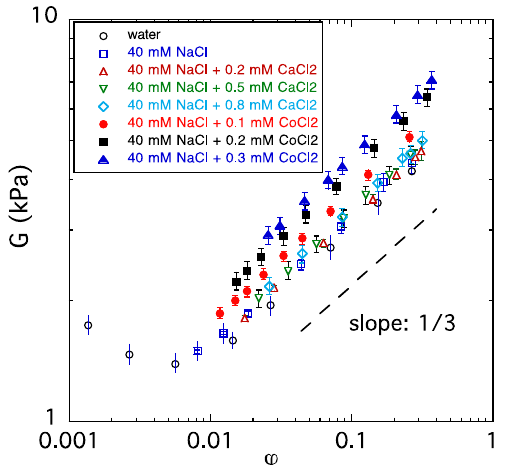
Figure 2. Variation in the shear modulus of PA gels swollen in different salt solutions and water.